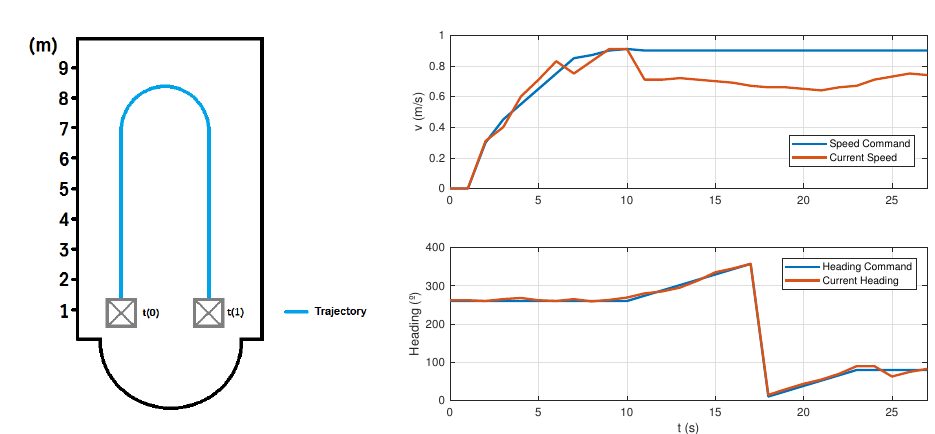
Figure 13. U-shaped trajectory test results. Position of the Strider V1.0 ( Left ) and current and reference speed and heading values during test ( Right ).